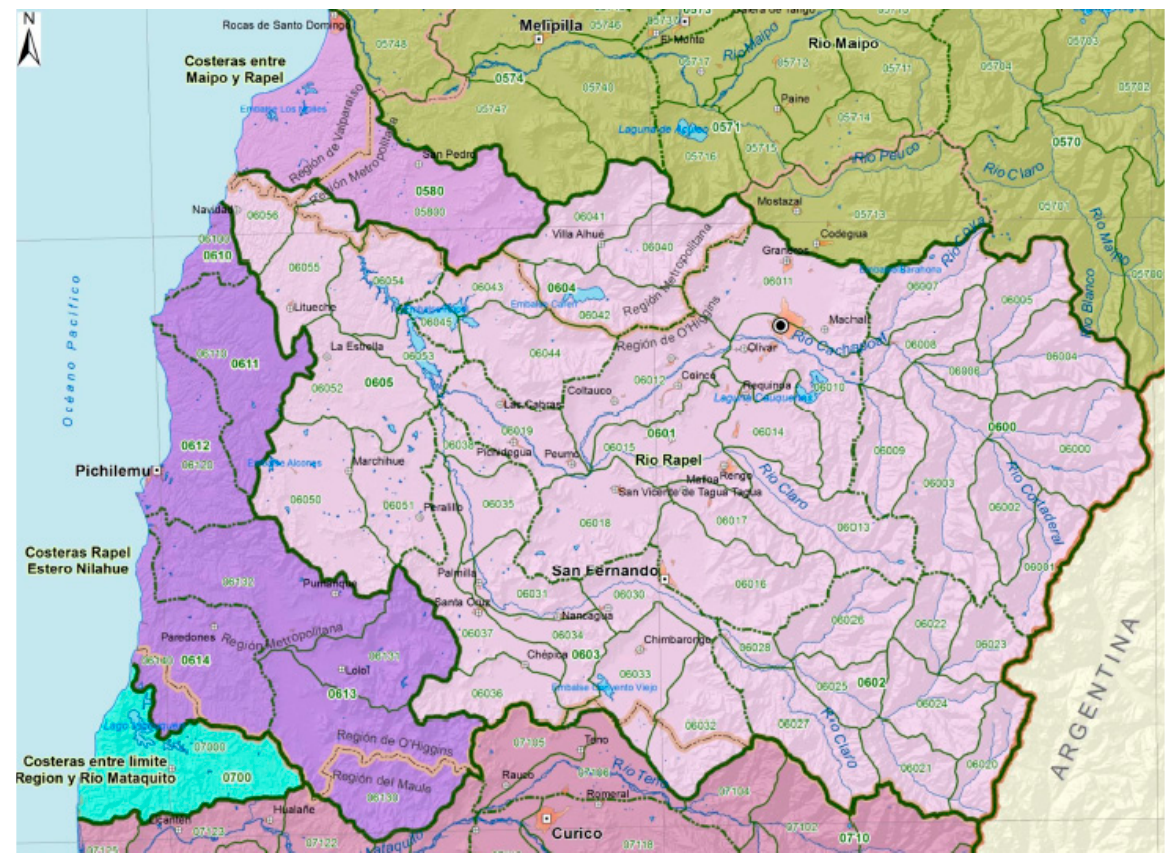
Figure 2. Division per basin, sub-basin, and sub-sub-basin in the Libertador Bernardo O’Higgins Region (based on DGA data [8], available online: https://dga.mop.gob.cl/administracionrecur- soshidricos/inventario_cuencas_lagos/Paginas/default.aspx, accessed on 9 June